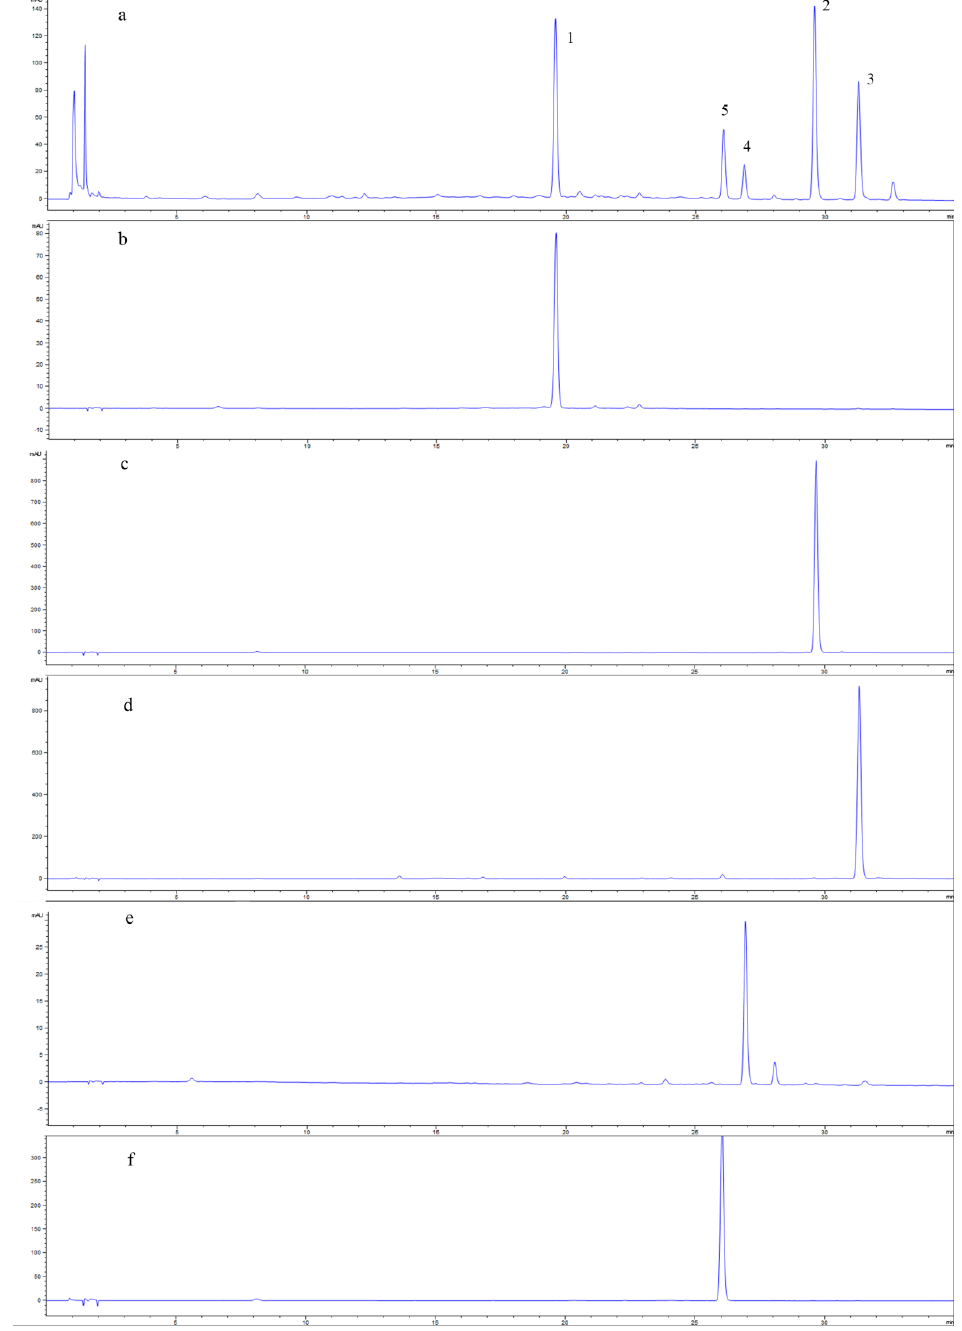
Figure 4. HPLC analysis compounds (( a ), extract crude; ( b – f ), compounds 1 – 5